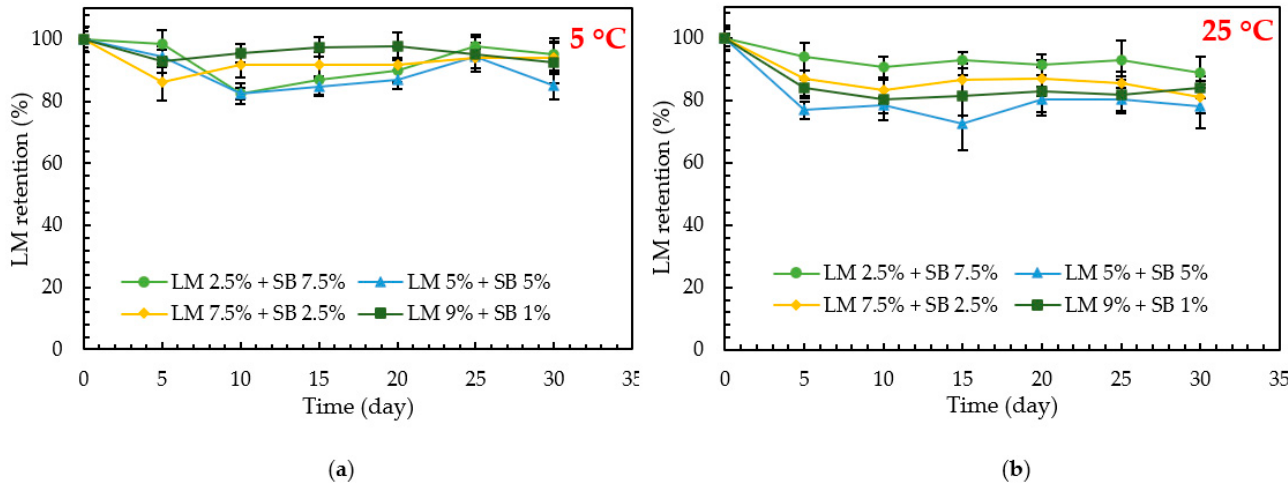
Figure 6. Retention of D-limonene in the emulsions during storage at ( a ) 5 ◦ C and ( b ) 25 ◦ C. Data are presented as mean ± standard deviation, n = 3.